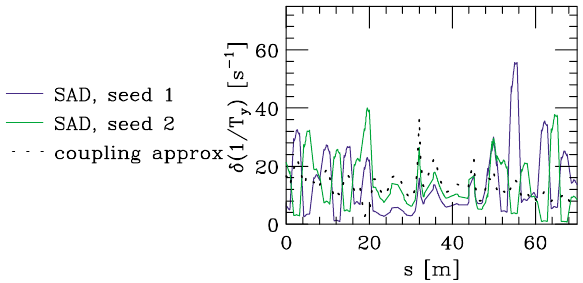
FIG. 3. (Color) Vertical steady-state (local) growth rate over 1 (cid:1) 2 the ATF for an example with vertical dispersion and x - y coupling due to random errors. Given are results obtained by SAD (for 2 seeds; solid curves) and by the coupling approxima- tion used here (dots). TABLE III. Steady-state IBS growth rates for an example in- cluding vertical dispersion and x - y coupling due to random errors.